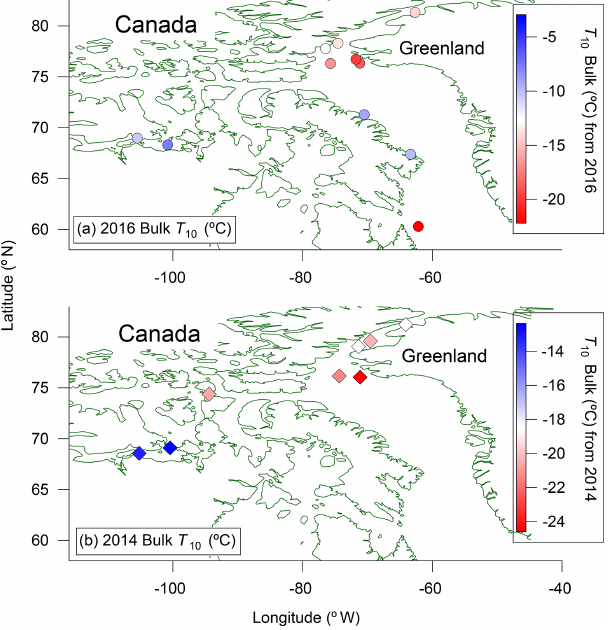
Figure 4. Spatial distributions of T 10 values in (a) 2016 and (b) 2014 for bulk